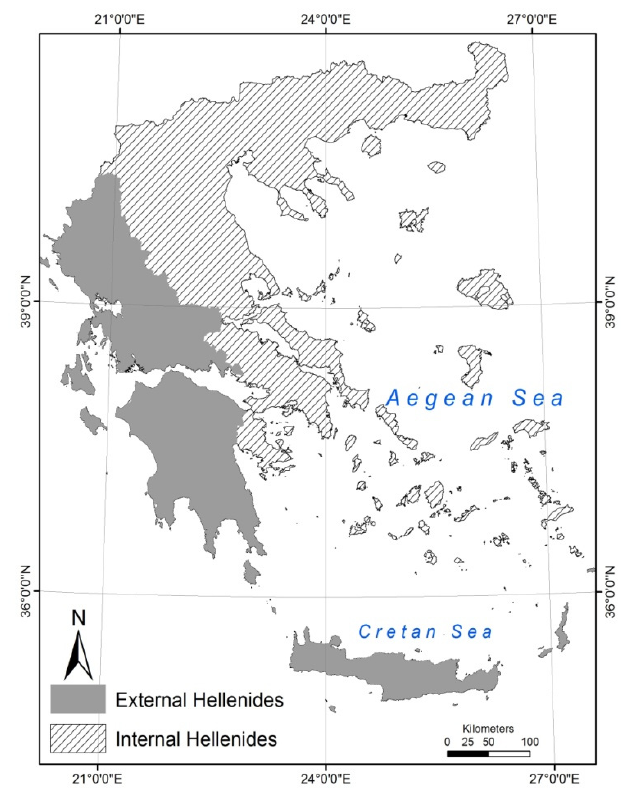
Figure 2. Map of Greece showing the division of Hellenides in External and Internal ones.